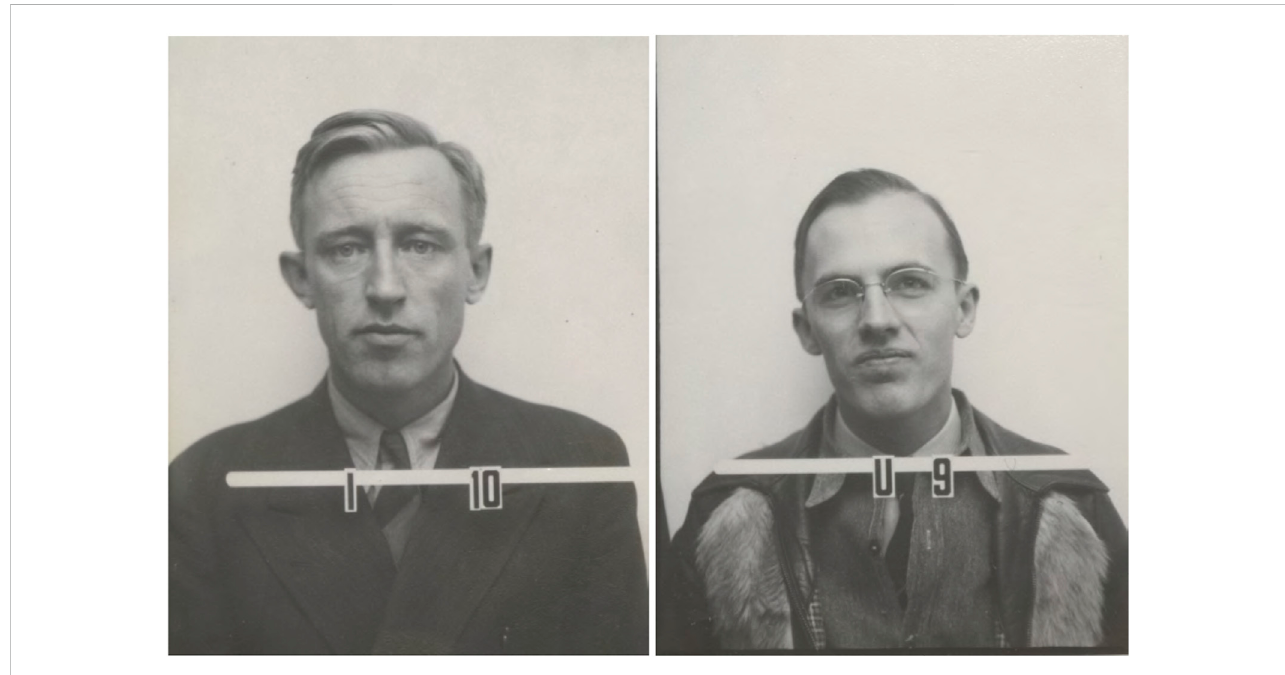
HansStaub,andHughRichards, LosAlamosbadgephotographsfrom1943.OurarchivistsatLosAlamosthinkthattheletterandnumberinfrontofeach portrait was simply the photographer ’ s book keeping way to ensure the correct picture went with the correct